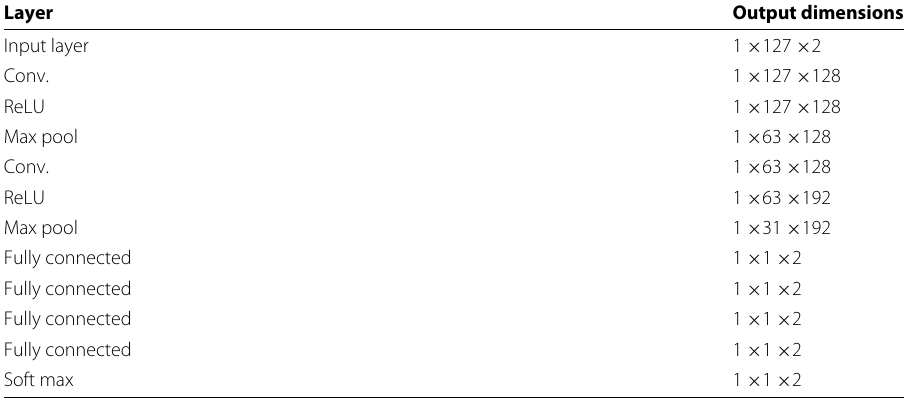
Table 2 The second adopted CNN network